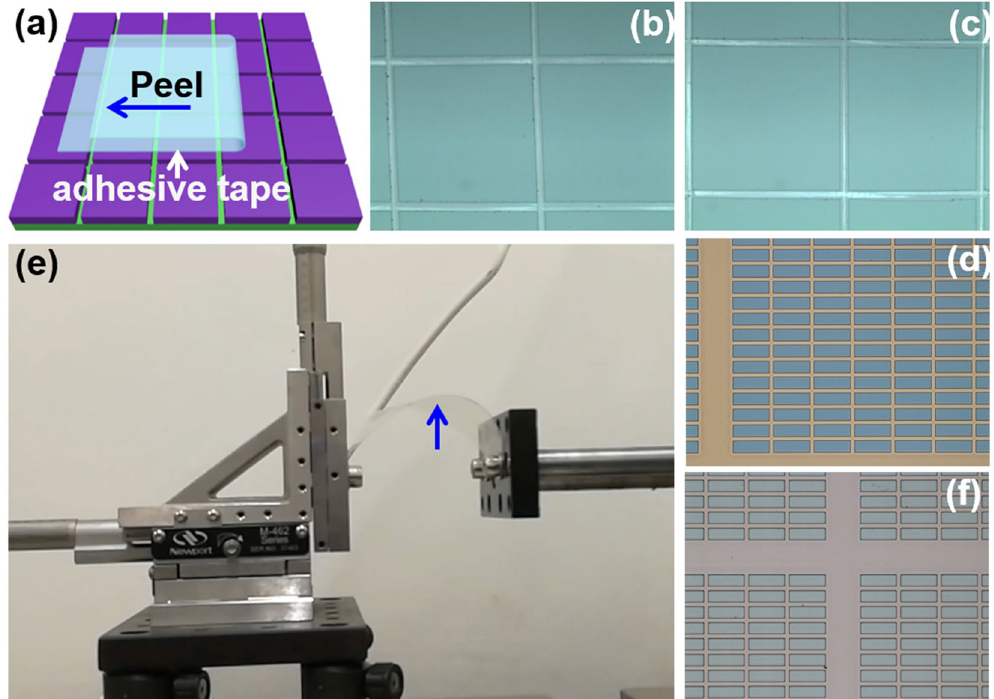
Figure 4. Tape test and bending test for adhesion. ( a ) Schematic illustration of tape test. ( b ) Typical images of tape test of SiO 2 on CYTOP without and ( c ) with 30 min. annealing at 150 °C. ( d ) Typical tape test results of SU-8/SiO 2 /CYTOP stack on Si wafer. (e) Bending test for structures on flexible substrate. ( f ) Images of the SU-8/SiO 2 /CYTOP stack on PET which was taken at the most strained area (arrow in ( e )) after bending test. Also see Supporting information